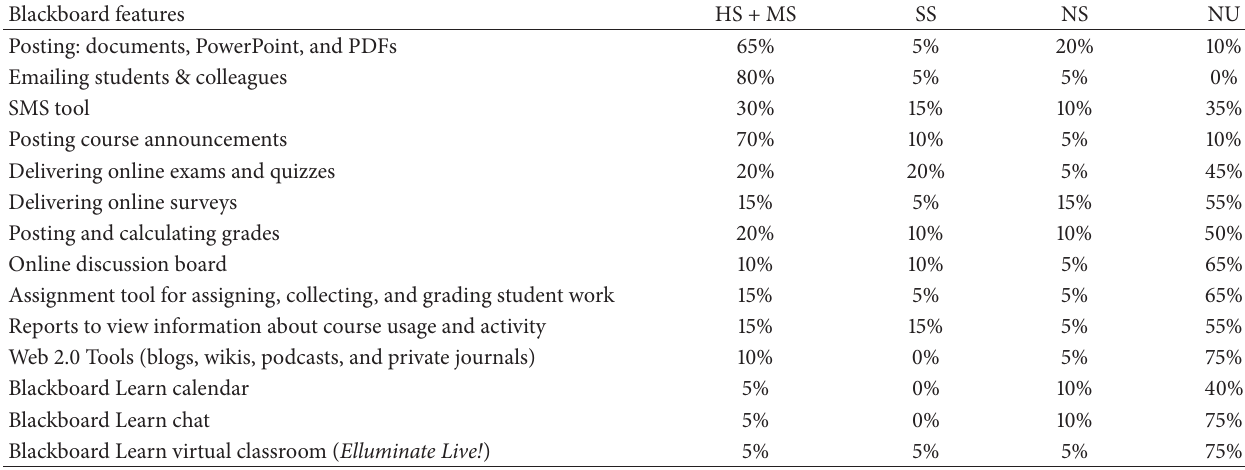
Table 5: Faculty usage of Blackboard features.